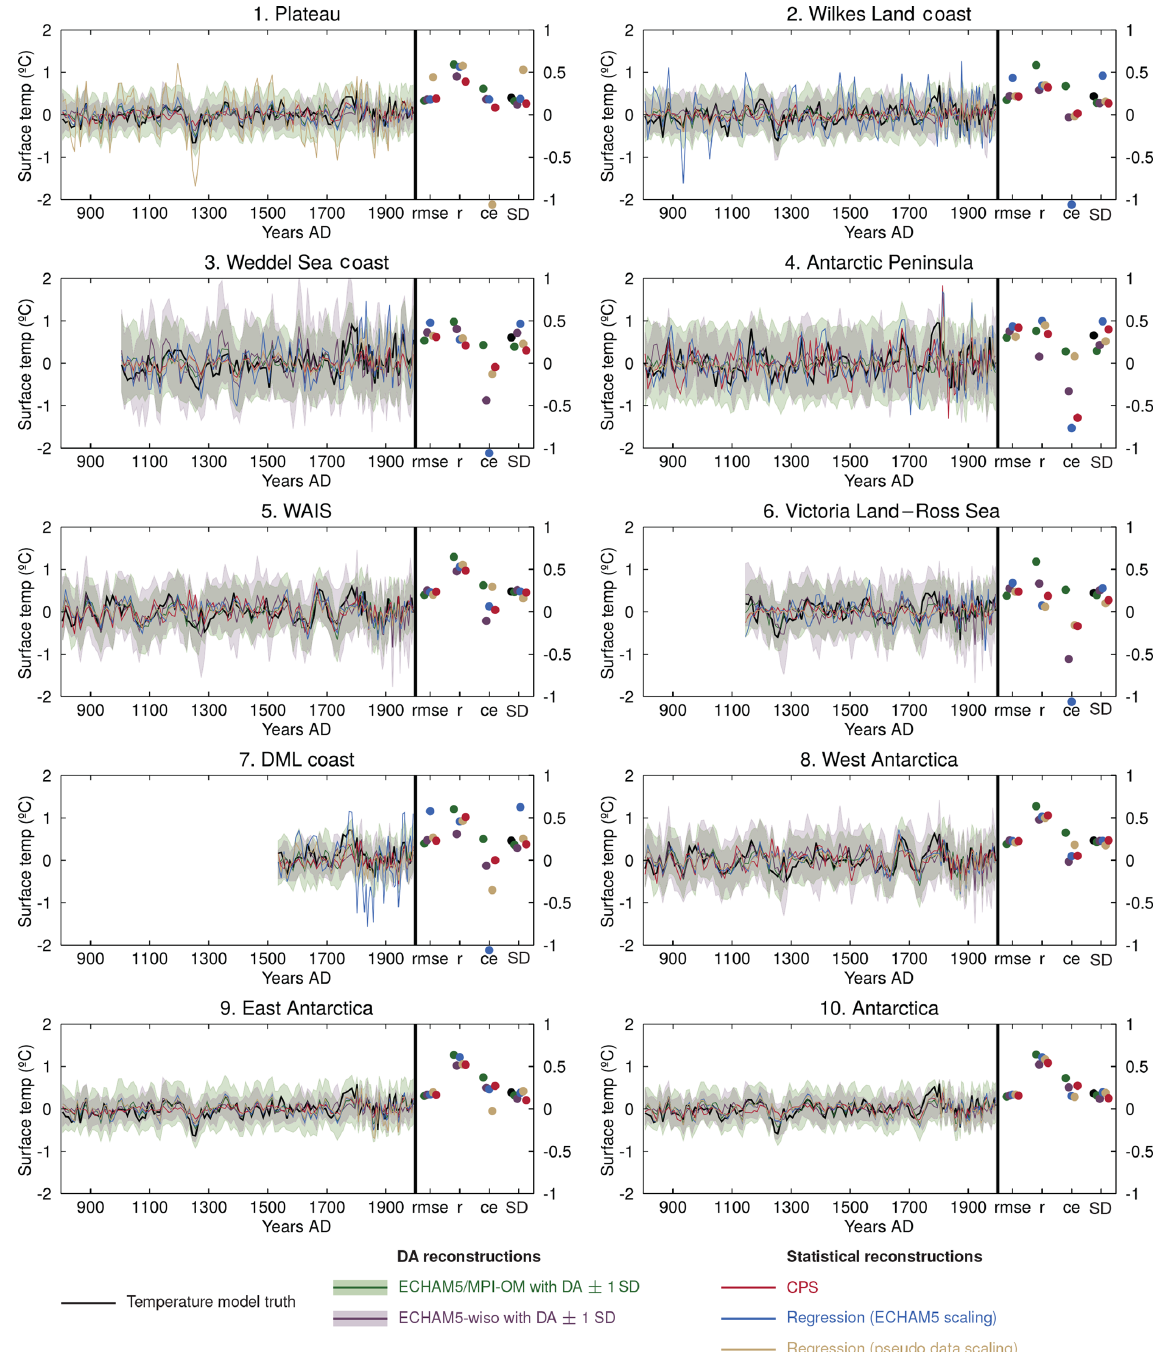
Figure 6. Changes in surface temperature over the 800–2000CE period in the model truth (ECHAM5/MPI-OM, from which the δ 18 O assimilated pseudoproxies are derived, in black), and in the different data assimilation (in green and violet, see Sect. 2.3) and statistical (in red, blue and beige, see Sect. 2.5) reconstructions based on the δ 18 O pseudoproxies (Fig. 5). The uncertainty of the data assimilation-based reconstructions is shown using colored shading ( ± 1 standard deviation of the model particles scaled by their weight around the mean). The results are 10-year averaged over the 800–1800CE period and 5-year averaged over the 1800–2000CE period. All series are anomalies using the whole periods as a reference. Diagnostics related to the skill of the reconstructions are displayed on the right of each panel: the RMSE between the reconstructions and the model target (rmse, ◦ C), the correlation coefficients between the reconstructions and the model target ( r ), the coefficient of efficiency of the reconstructions (ce), and the standard deviation of the reconstructions and the model target (SD). Coefficient of efficiency values that are lower than − 1 are displayed just above the label